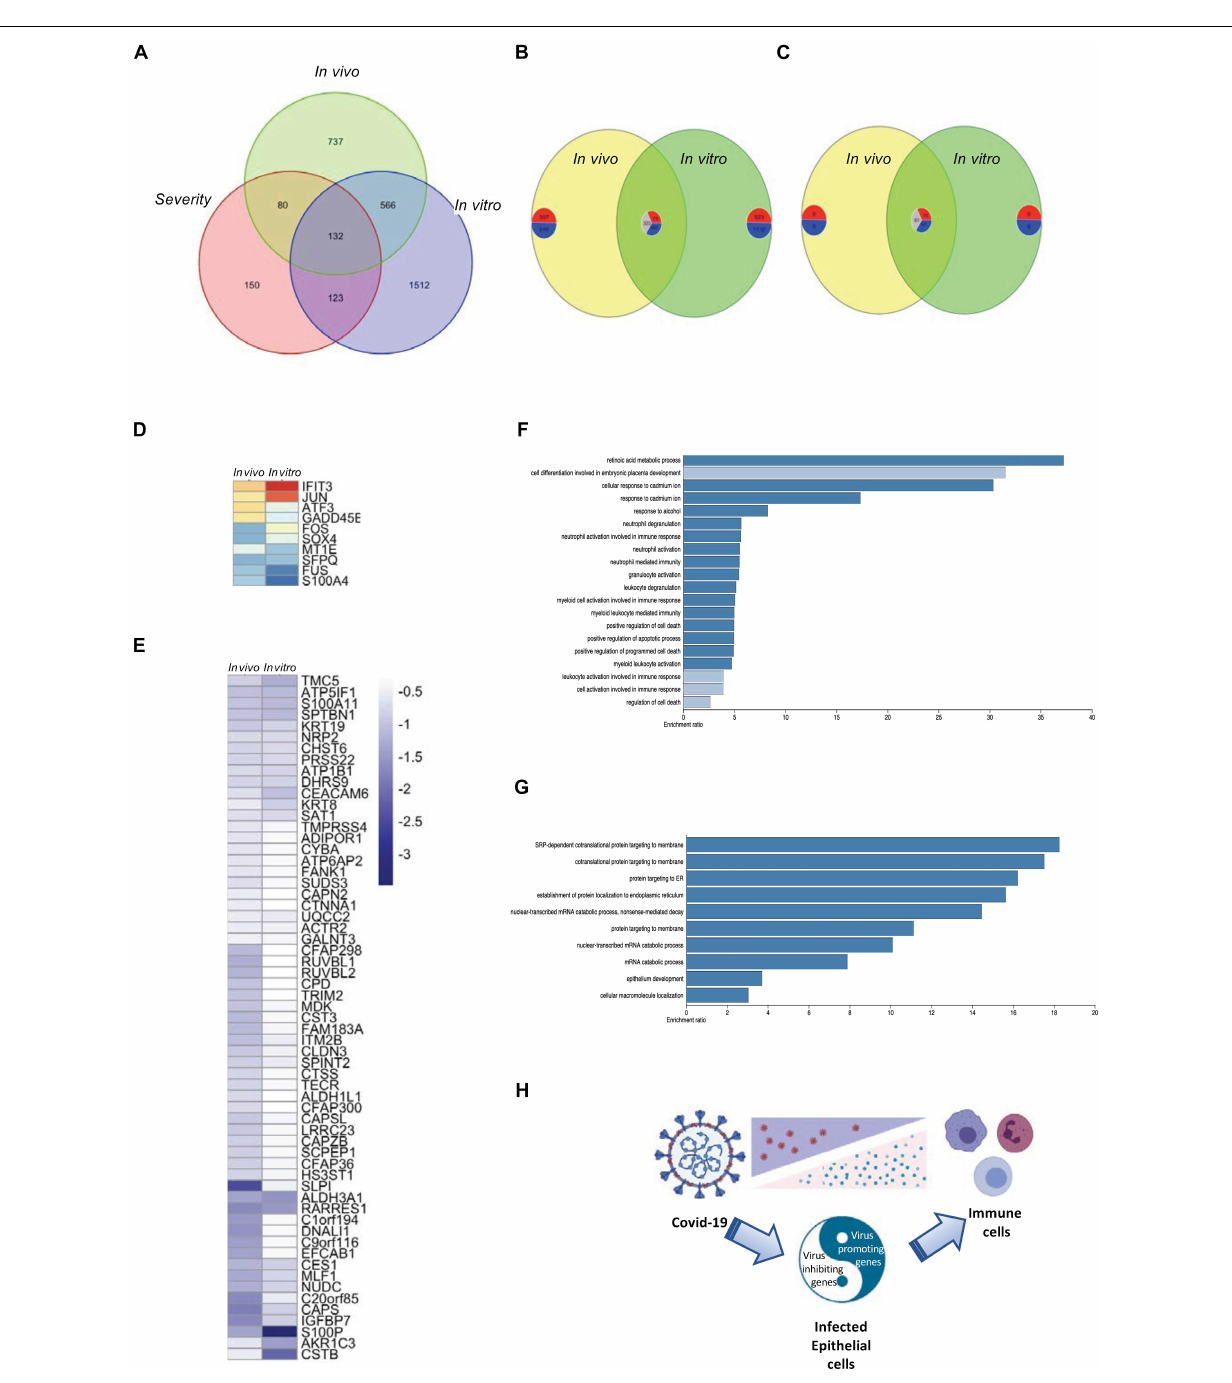
Frontiers in Cell and Developmental Biology |